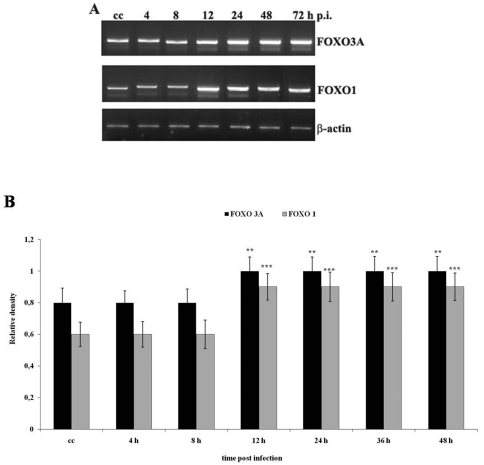
Expression of FOXO3A and FOXO1 cDNA of mock-infected and infected cells at the indicated times at different post infection.(A) The RT-PCR products were examined by 1.6% agarose gel electrophoresis. (B) Densitometric analysis of the corresponding band to FOXO3A and FOXO1. The bars represent the mean ± SEM of the results from three separate experiments. Significant differences between CCoV-II-infected cells and control cells are indicated by probability P. **P <0.01 and ***P <0.001.